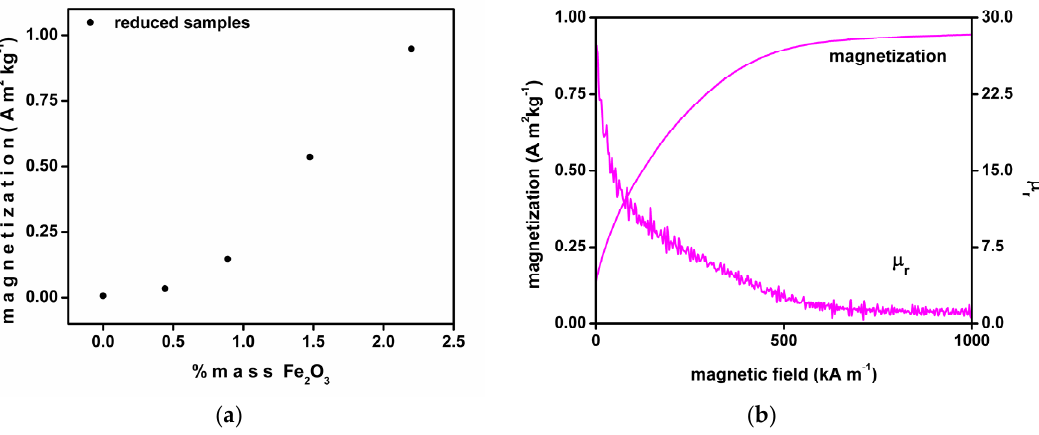
Figure 6. Magnetic properties of reduced samples obtained after Fe-doping: ( a ) Saturation of magnetization; ( b ) comparison between hysteresis curve and relative permeability.